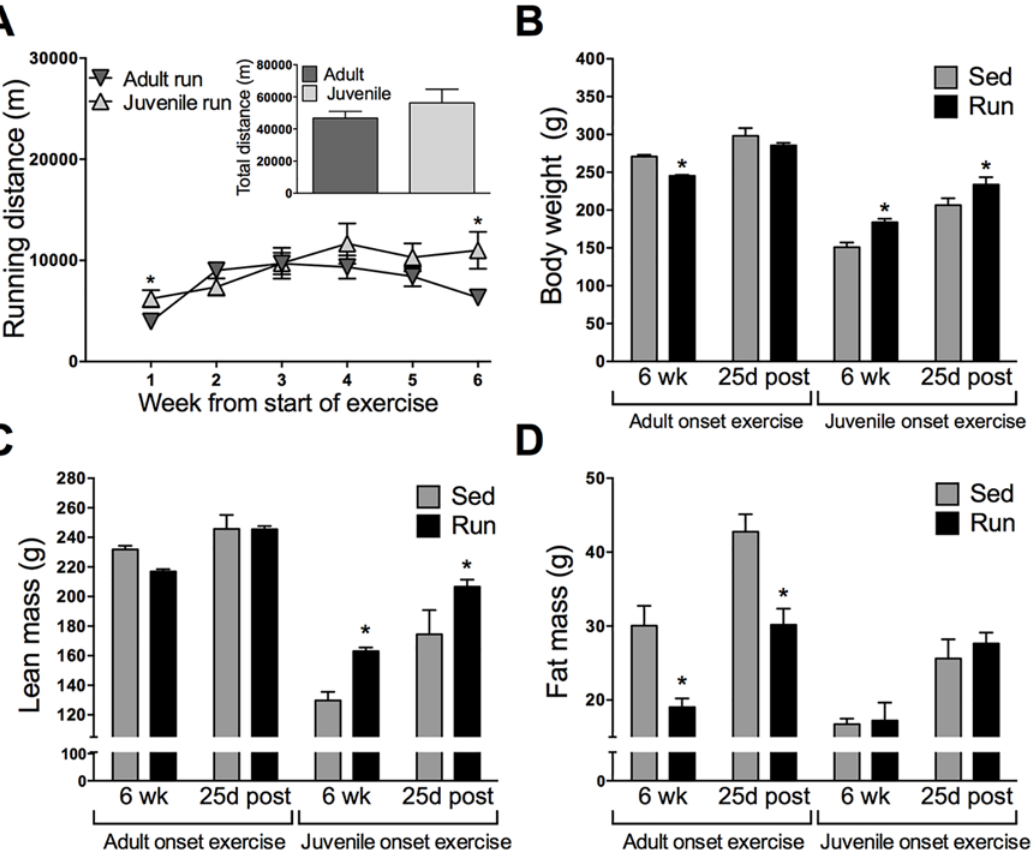
Fig 6. Effects of age of exercise onset on body composition across the lifespan. A) Weekly total running distance across time for the separate cohort used for chemical carcass analyses. Adult runners ran less toward the end of exercise, whereas running distance steadily increased for juvenile runners throughout the duration of exercise. Total distance summed across six weeks did not differ by age. B-D depict body weight, lean mass and fat mass, respectively, for juvenile and adult run and sed chemical carcass rats after six weeks of exercise (6 wk) or 25 days following exercise cessation (25d post). B) Body weight; adult runners weighed less than adult seds at 6 wk, however they returned to sedentary levels 25d post. In contrast, juvenile onset runners consistently weighed more than their sedentary counterparts at both time points. C) Lean mass; juvenile onset runners had sustained increases in lean mass at both time points. D) Fat mass; sustained decreases in fat mass were observed in adult onset runners only. Data are represented as mean ± SEM; * p <